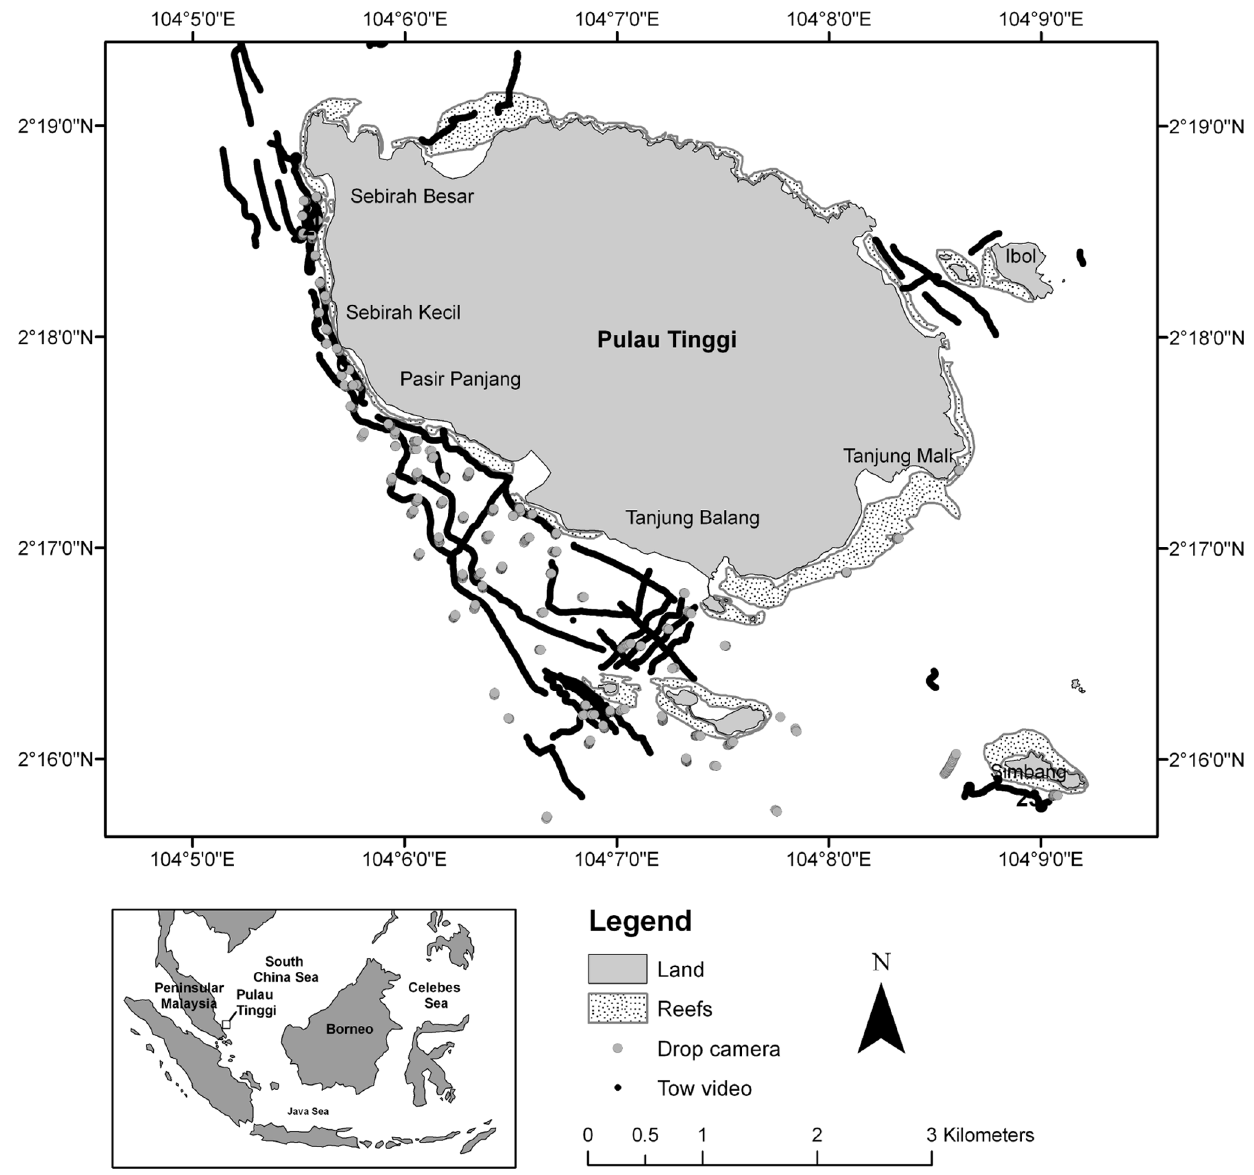
Figure 1. Location of tow video, drop video, and seagrass sampling points around Pulau Tinggi, southeast Peninsular Malaysia. Tow video points have converged to form tracks. absence at coordinates m a . A low variance ( c I ( h ; z k )) is closer to 0, corresponding to high correlation or continuity. combination of the accepted models (spherical, exponential, Gaussian, nugget-effect) [31]. The variogram model parameters are (1) the sill (heterogeneity of species occurrence), i.e. the semivariance on the y-axis where the variogram reaches its asymptote, which is approximately the global variance of the data; (2) the range (maximum diameter of species patches or gaps), i.e. the distance on the x-axis where the semivariogram reaches its asymptote and beyond which all points are spatially uncorrelated; and (3) the nugget ; i.e. the semivariance on the y-axis at the ordinate of the variogram due to measurement error and fine spatial-scale